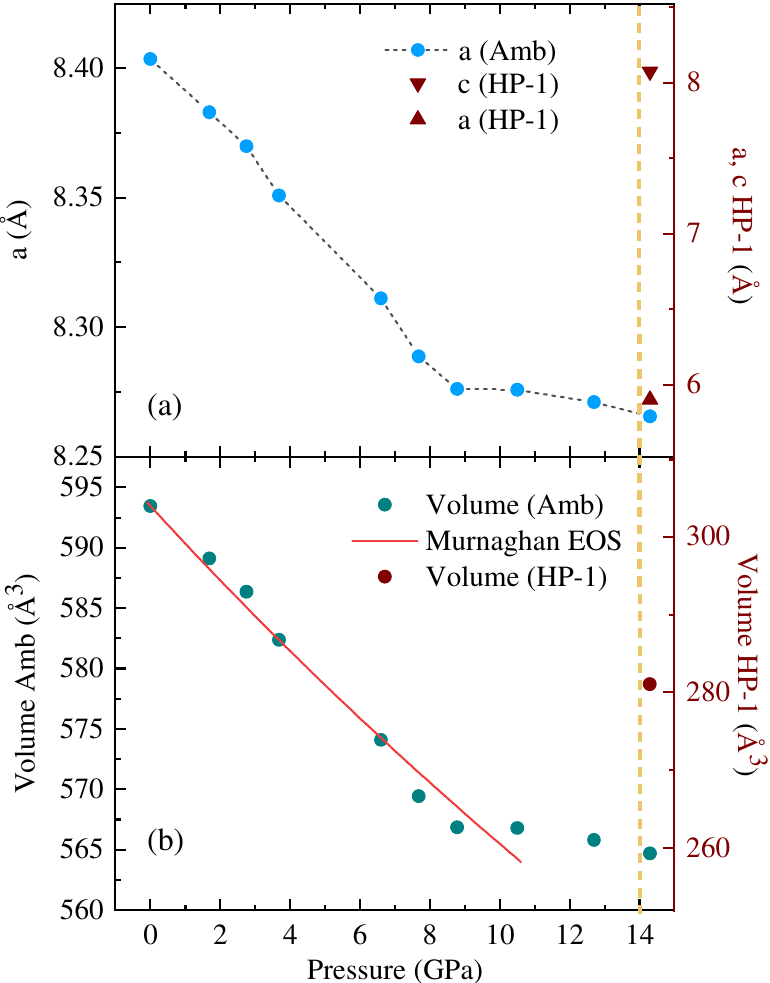
Figure 8. ( a ) Experimental lattice parameters a and c and ( b ) volume per unit cell V of the ambient phase and high-pressure HP-1 phase (scale on the right side of the graph) as a function of pressure. The pressure dependence of the volume is fitted with a Murnaghan equation of state (EOS), as defined in the